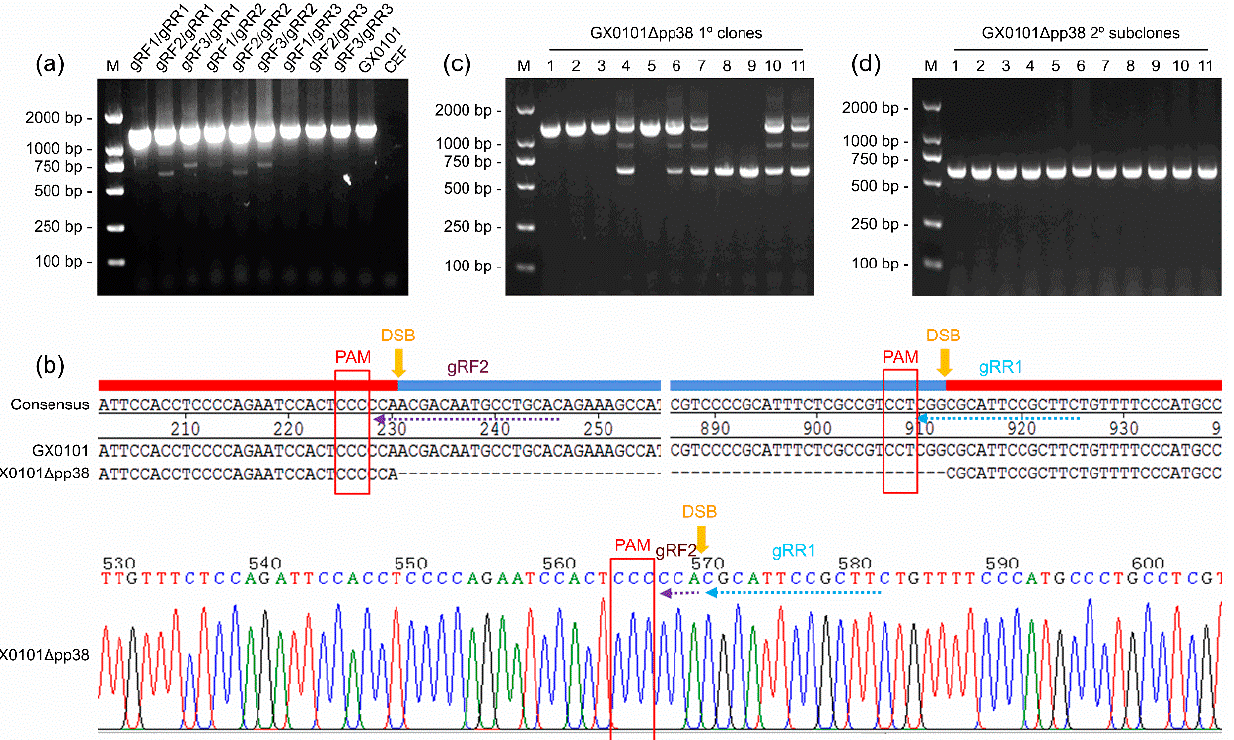
Figure 1. PCR analysis and sequence alignment of the double-strand breaks in pp38-deleted MDV mutants: ( a ) PCR analysis of the mutated or wild-type pp38 genes of GX0101 edited by crossed combinations of different gRNAs. ( b ) Sequence alignment of double-strand breaks (DSBs) in pp38 genes mutated by the gRNA combination gRF2/gRR1. ( c , d ) PCR analysis of pp38 deletions in single MDV plaques from the first and second rounds of virus purification, respectively. Due to limited space, only some of the results are shown here. The entire or broken gRNA sequences and protospacer-adjacent motifs (PAMs) are shown by same-colored arrows or square frames in red, respectively.